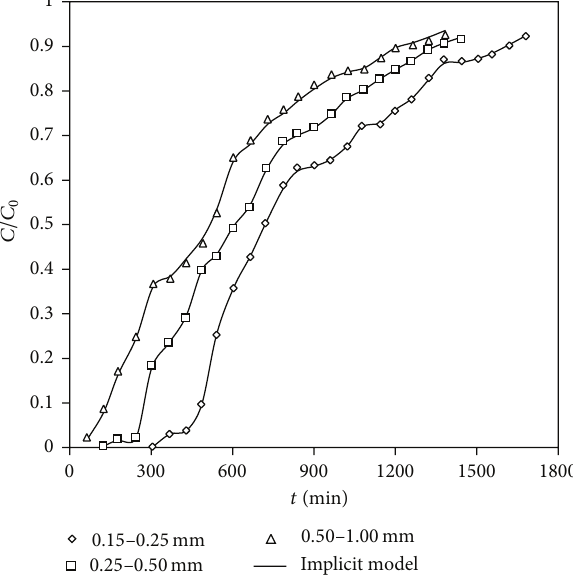
Figure 8: Breakthrough curves of Cr(VI) adsorption onto waste acorn of Quercus ithaburensis fitted with (2)